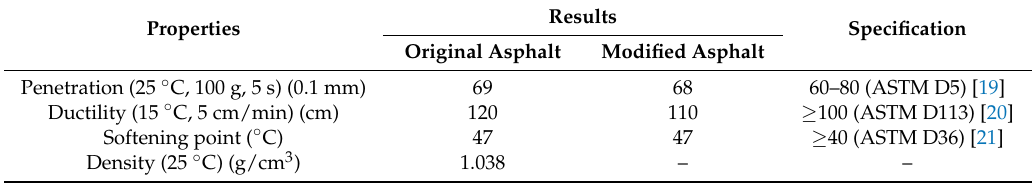
Table 1. Properties of original asphalt and modified